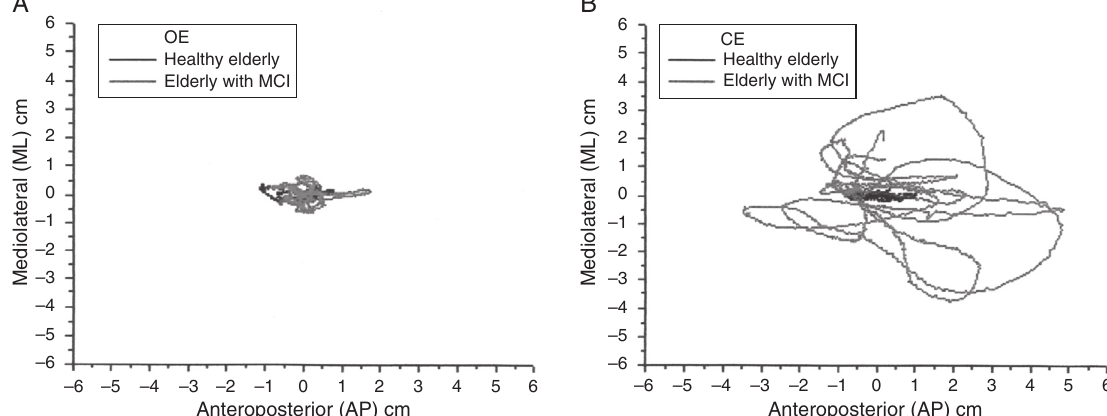
Figure 2 Statokinesiogram from a healthy elderly and of another with mild cognitive impairment (MCI). A, open (OE) and B, closed (CE) eyes in anteroposterior (AP) and mediolateral (ML)